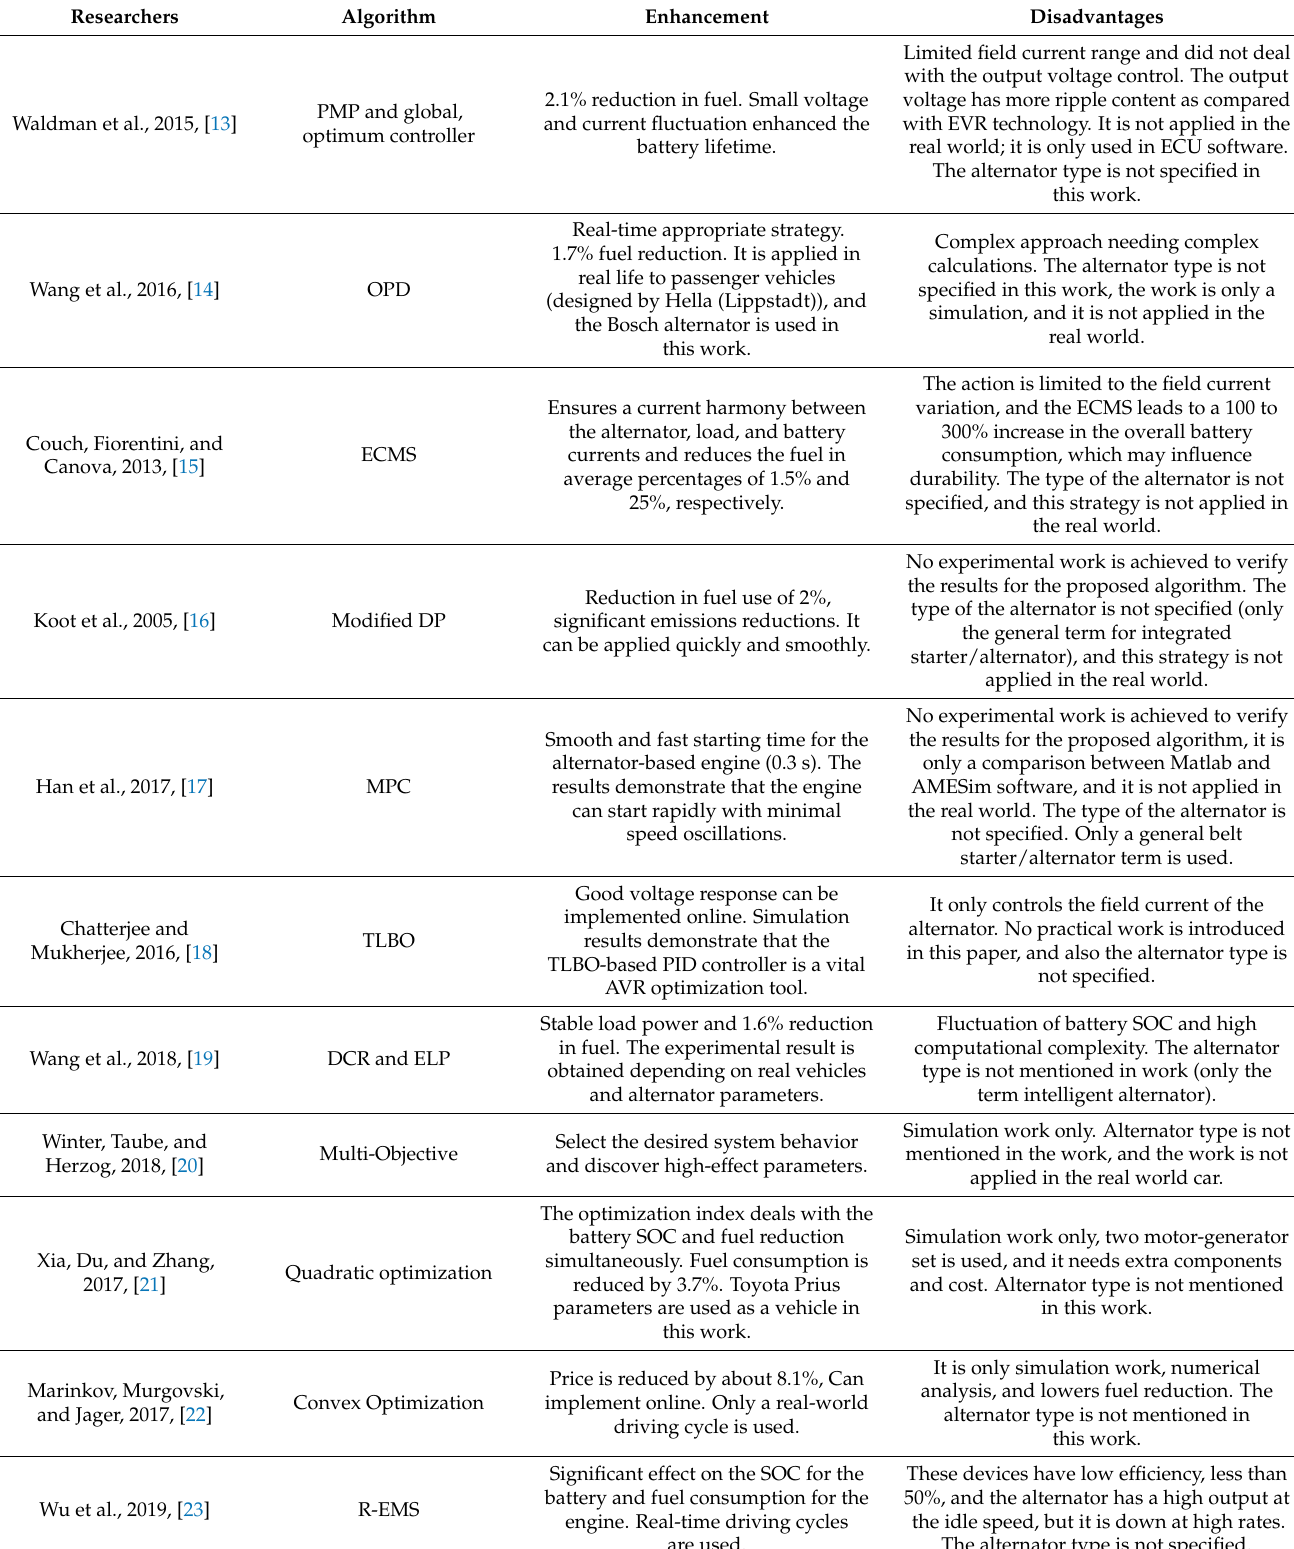
Table 2. Summary of the Optimization Techniques Used in the